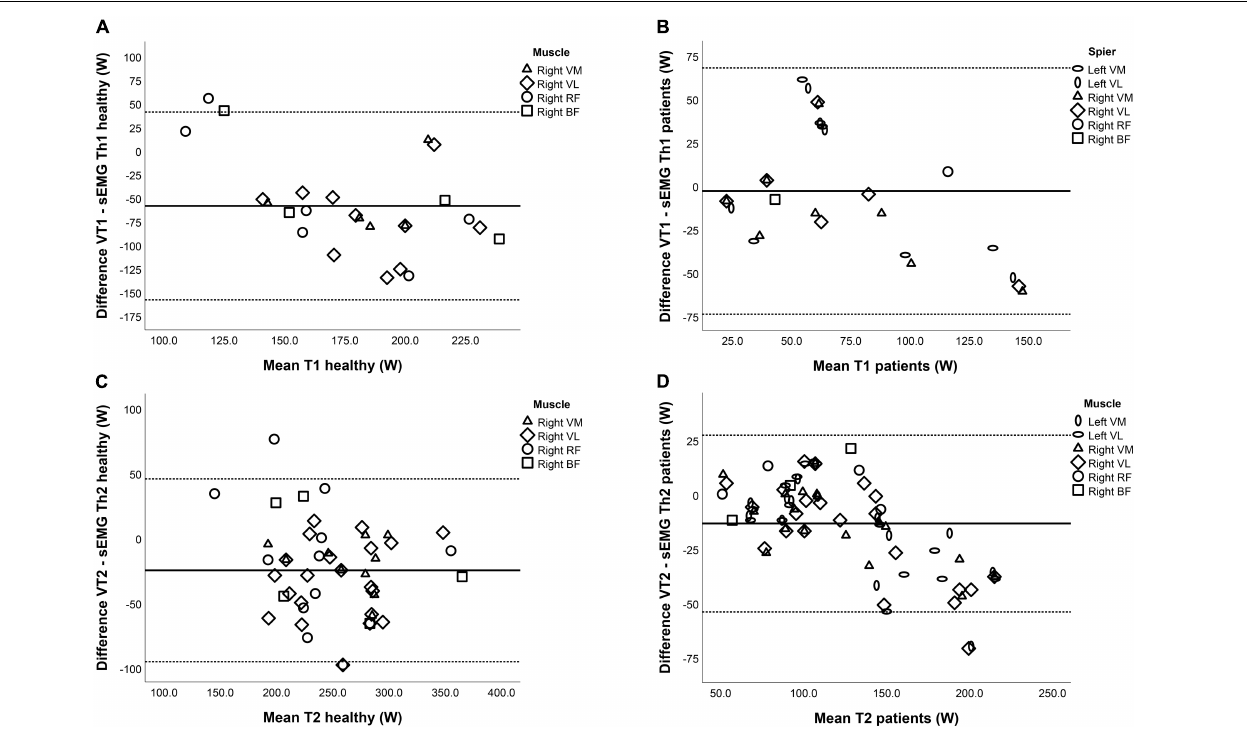
FIGURE 4 | Bland–Altman plots for the relation between the ventilatory thresholds (VTs) and surface EMG thresholds (sEMG Ths) of (A) Th1 in healthy controls, (B) Th1 in neuromuscular disorder (NMD) patients, (C) Th2 in healthy controls, and (D) Th2 in NMD patients. The horizontal lines represent the mean difference (bias) and two standard deviations, i.e., limits of agreement of the differences between the VTs and sEMG